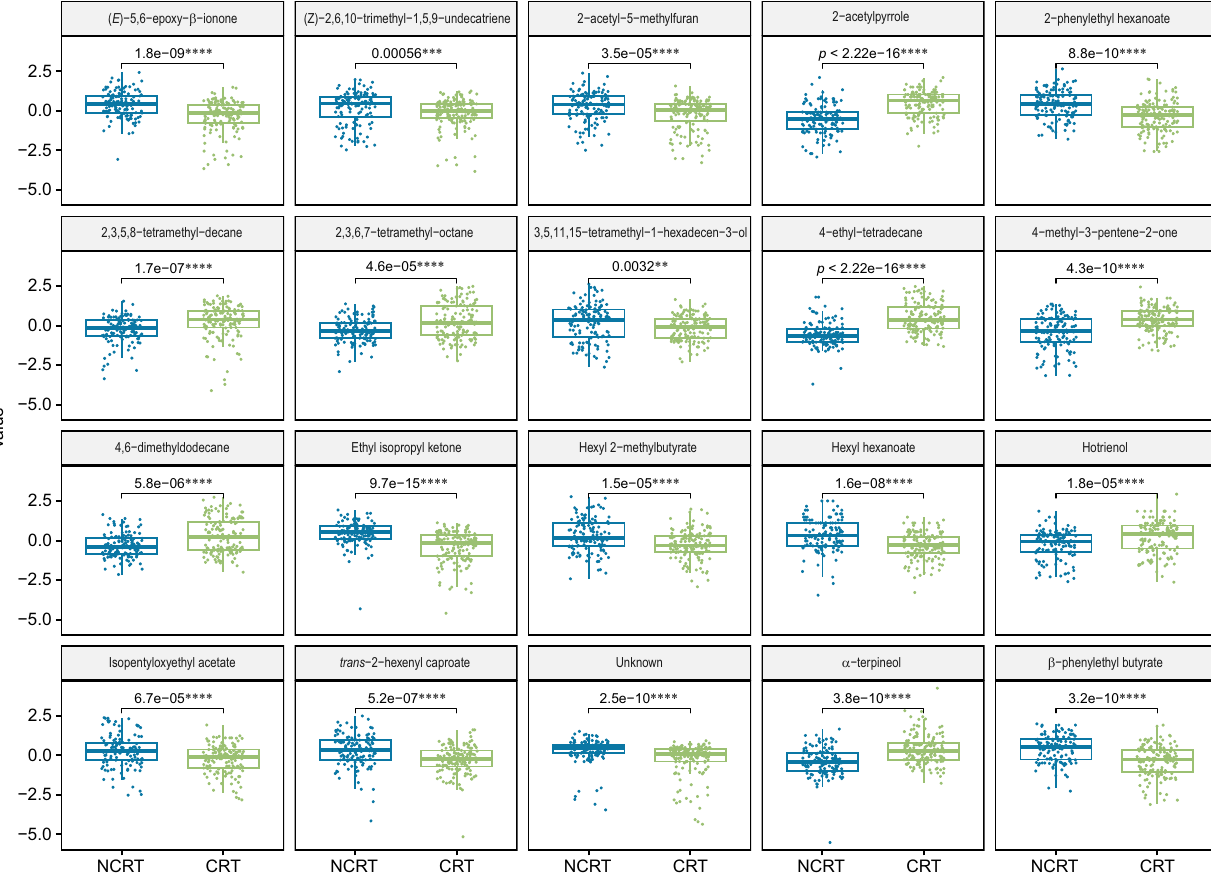
Fig. 3 Boxplots showing the levels of differential volatile metabolites between CRT and NCRT Wuyi rock tea samples based on Wilcoxon test. The relative abundance of volatiles with signi fi cant differences was presented using log10-transformed Z-score values. ** p < = 0.01, *** p < = 0.001, **** p < = 0.0001. The box represents the interquartile range, with the median shown as the horizontal line inside the box. The bottom and top boundaries of the box represent the 25th and 75th percentiles, while the lower and upper whiskers correspond to the 5th and 95th percentiles. Table 2. Comparison of the prediction results with different